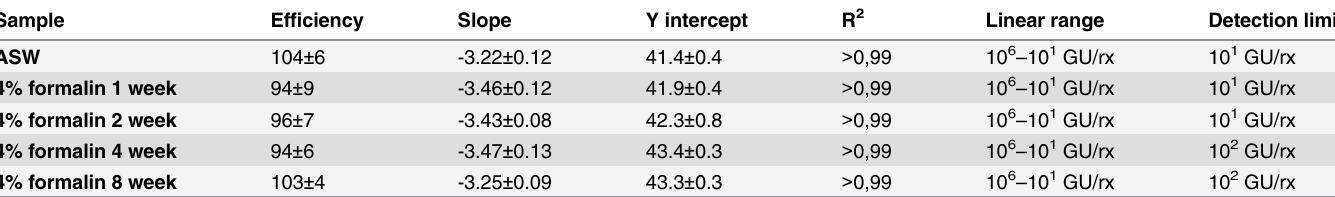
The values of Ef fi ciency, Slope and Intercept are expressed as mean ± standard deviation calculated from two spiking experiments with V . cholerae ATCC 39315 cells, each quanti fi ed in triplicate on the same run (n = 6)